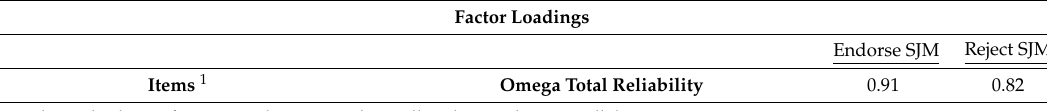
Table 3. Summary of Exploratory Factor Analysis of the Spiritual Jihad Measure Using Ordinary Least Squares Estimation from a Polychoric Correlation Matrix and Direct Oblimin